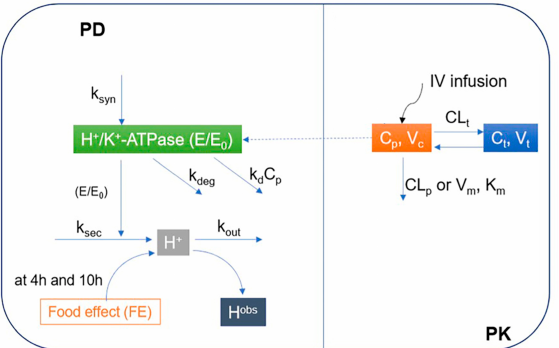
Figure 1. Proposed mechanism-based pharmacokinetic/pharmacodynamics (PK/PD) model of ilaprazole in Chinese volunteers. PD: Pharmacodynamics; PK: Pharmacokinetic; E/E0: Relative baseline H + /K + -ATPase activity; ksyn: H + /K + -ATPase synthesis rate constant; kdeg: H + /K + -ATPase degradation rate constant; ksec: Secretion rate constants for intra-gastric H + concentration; kout: Elimination rate constant for intra-gastric H + concentration; kd: Irreversible inhibition efficacy of H + /K + -ATPase by ilaprazole; Cp: Concentrations in central compartments; Ct: Concentrations in peripheral compartments; Hobs: Observed concentration of H + ; Km: Michaelis-Menten constant; Vm: Maximum rate of metabolite production; Vc: Distribution volume of central compartment; Vt: Distribution volume of peripheral compartment; CLp: Clearance from the central compartment; CLt: Clearance from the central compartment to the peripheral compartment; IV infusion: Intravenous infusion.